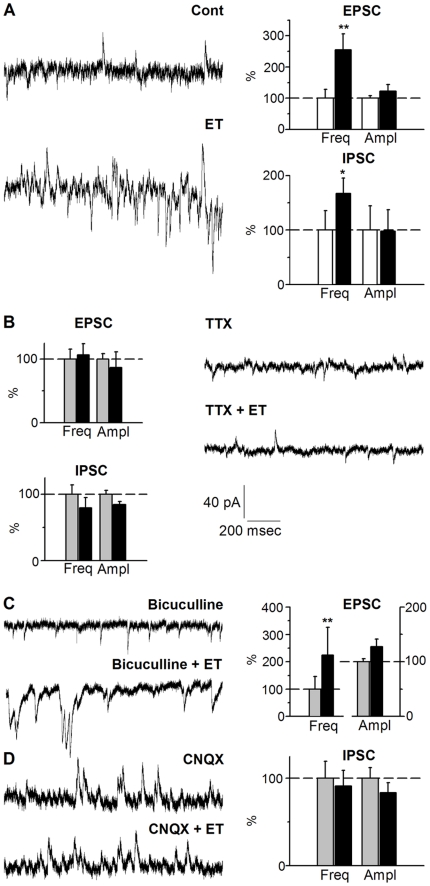
ET stimulates excitatory and inhibitory synaptic transmission onto the Purkinje cells.A, right: spontaneous PSC detected in voltage-clamped Purkinje cells maintained at −60 mV, in absence (Cont) or 5 min after ET (10−7 M) application. The relative mean frequencies (Freq) and amplitudes (Ampl) of spontaneous EPSC (upper graph) or IPSC (lower graph), before (white bar) or 5–7 min after 10−7 M ET was added (black bar), n = 15 distinct experiments. B–D, same kind of measurements but after pre-treatment (B) with TTX (10−6 M for 10 min, n = 18, (C) with bicuculline (10−5 M for 5 min) to block the IPSC (n = 17), or (D) CNQX (10−5 M for 5 min) to block the EPSC (n = 18). The frequencies and amplitudes are presented as percent of control condition (i.e. without any treatment, white bars) or after pre-treatment (grey bars), and after subsequent application of ET (black bars). **: p<0.01, *: p<0.05, otherwise n.s. Same scale for all current traces.